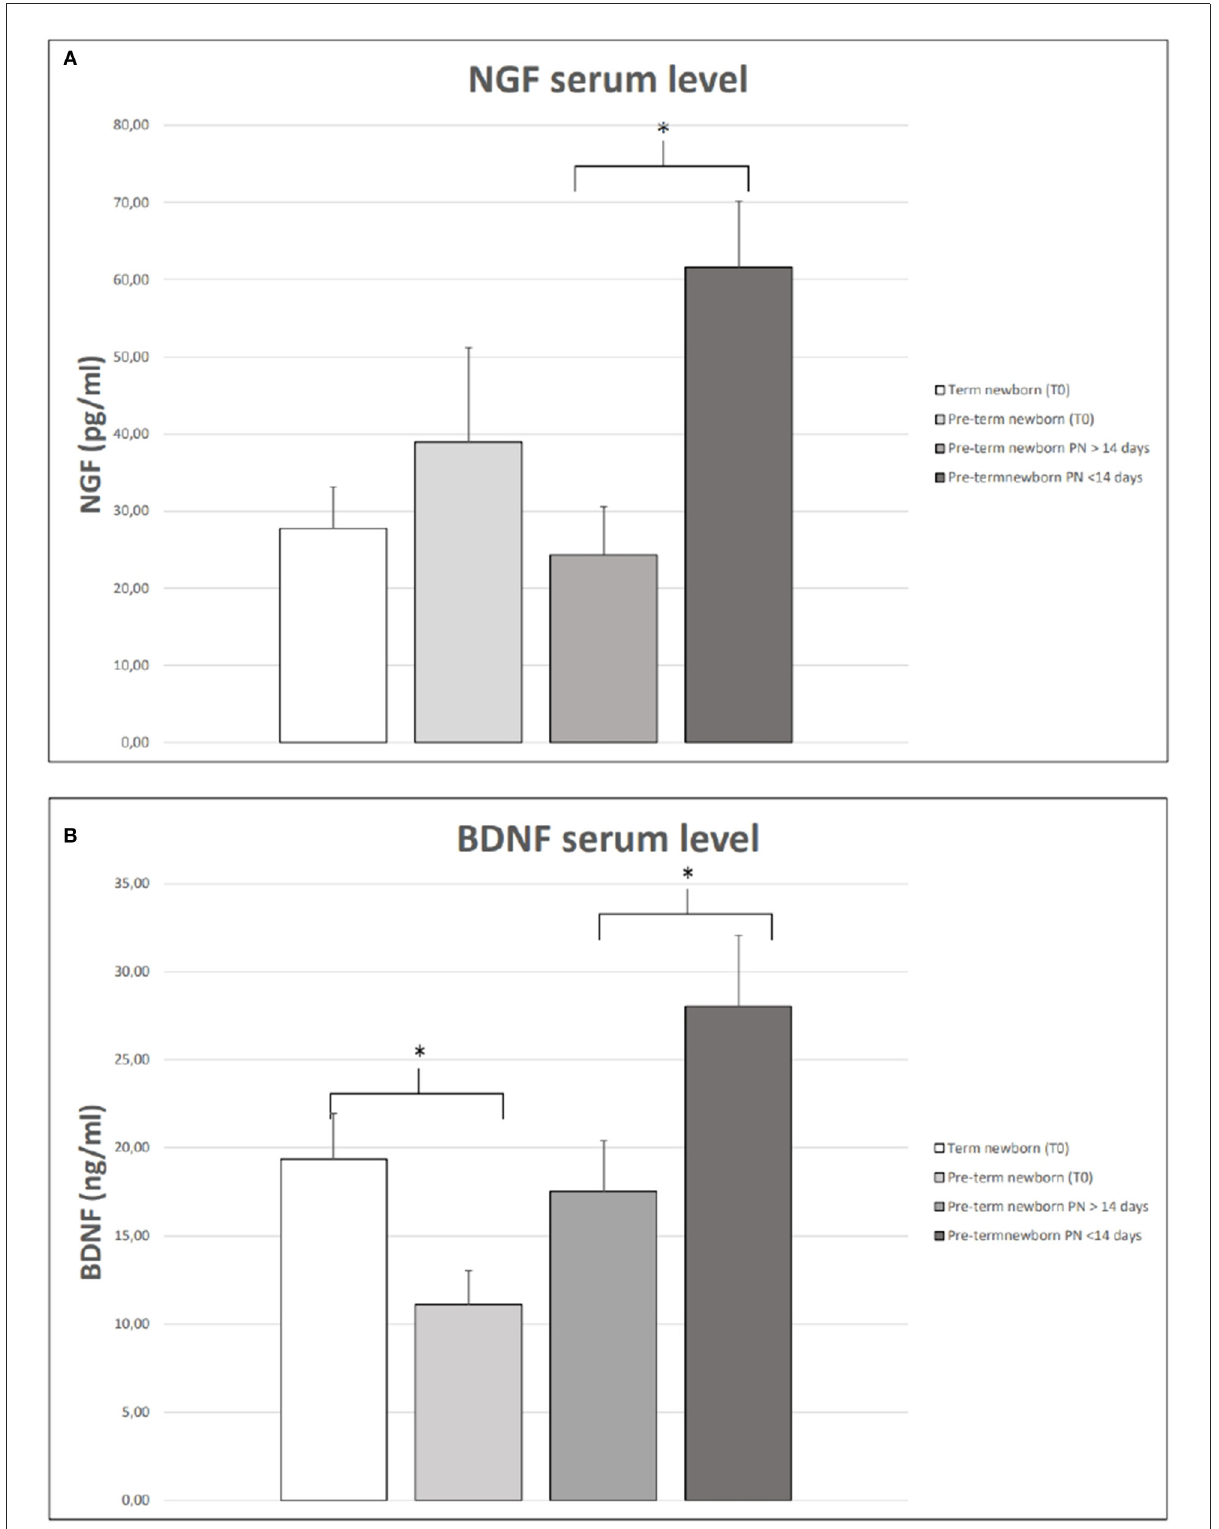
FIGURE1 NGF (A) and BDNF (B) serum levels in term and preterm neonates at birth (T0). Serum NGF (A) and BDNF (B) at 28 days of life in preterm babies receiving parenteral nutrition (PN) for more or less 14 days of life. The vertical lines extending from each box represent the standard error. The asterisks indicate significant differences between groups (* p <